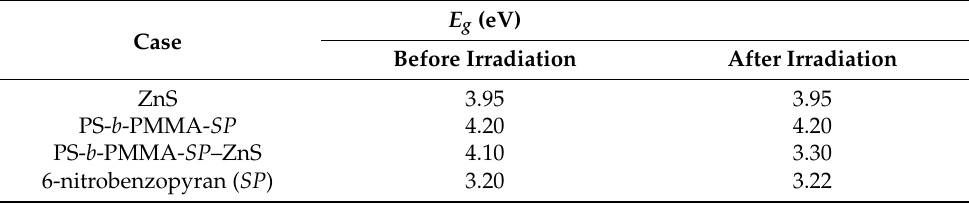
Table 1. Optical band gap E g estimated from Tauc plot 1